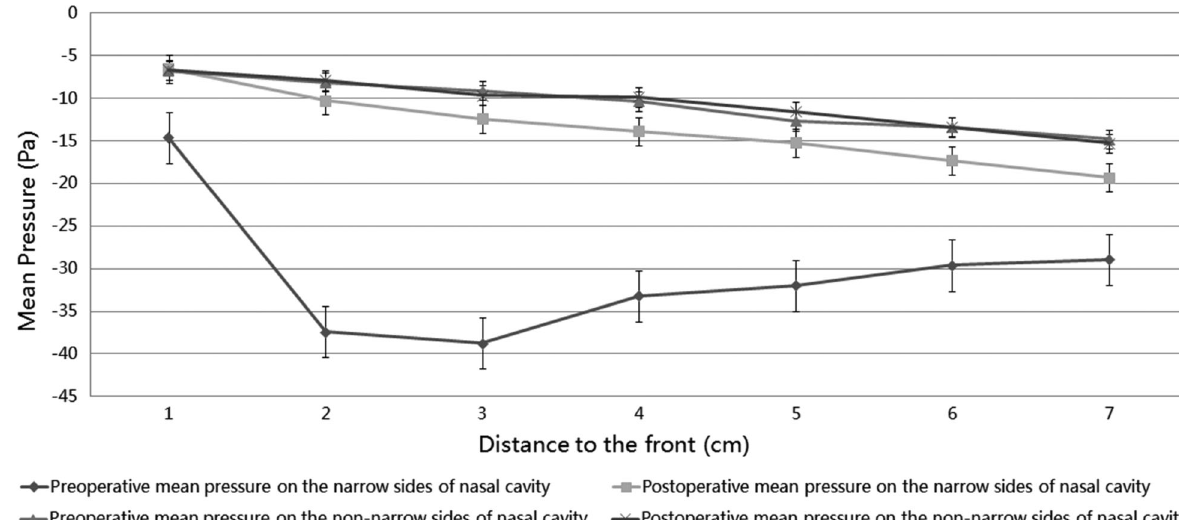
Figure 8. Pre- and postoperative mean pressure on representative cross-sections of the narrow and non-narrow sides of the nasal cavity.